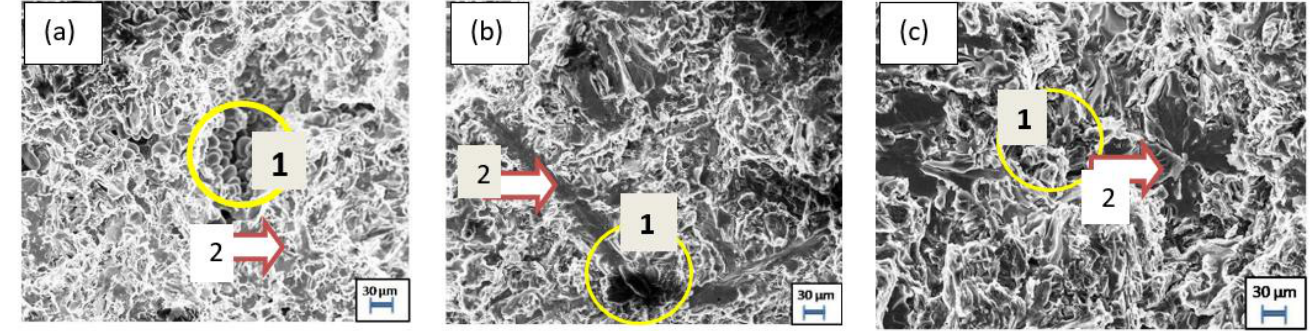
Figure 10. Fractographs of different specimens: ( a ) AF9C, ( b ) AF12C, and ( c ) AF15C (1(circle) — Ductile and 2(arrow) — Brittle fracture).